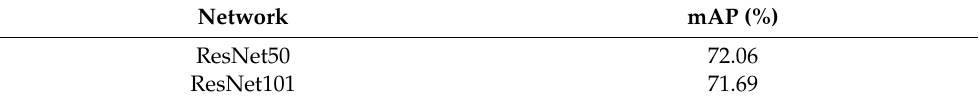
Table 5. Results on our dataset for ResNet50/101 without using any augmentation